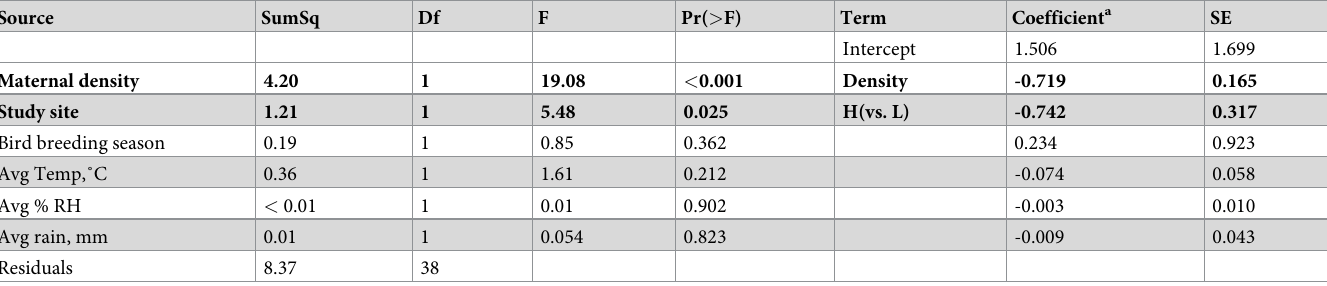
Table 3. Analysis (ANOVA) of population growth of P . downsi females in relation to effects of biotic and abiotic factors.